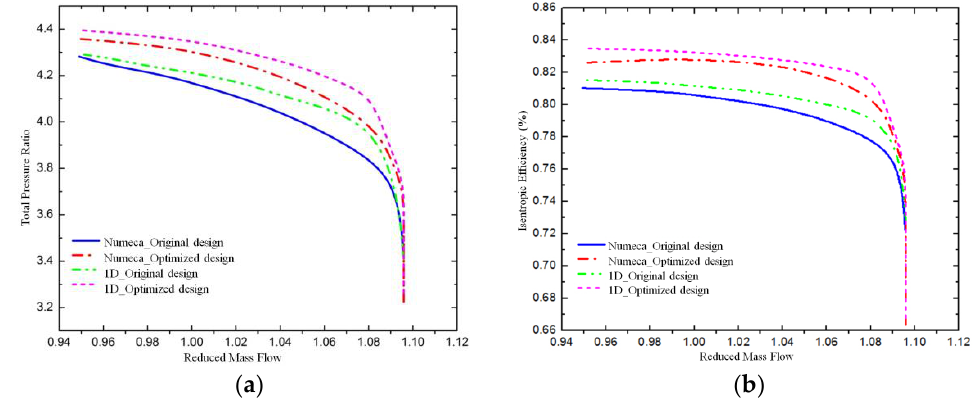
Figure 8. Performance map of the original and optimized designs for the low-pressure stage: ( a ) Reduced mass flow vs. total pressure ratio; ( b ) Reduced mass flow vs. isentropic efficiency.